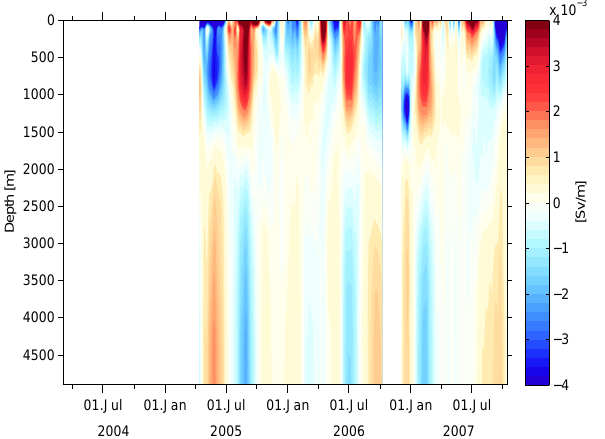
Fig. 10. Anomalies (time mean subtracted) of the transport per unit ) depth as a function of time and depth, derived from EBH ( T EBH AMOC and assuming steady western-boundary conditions. The data are 10-day low-pass filtered.